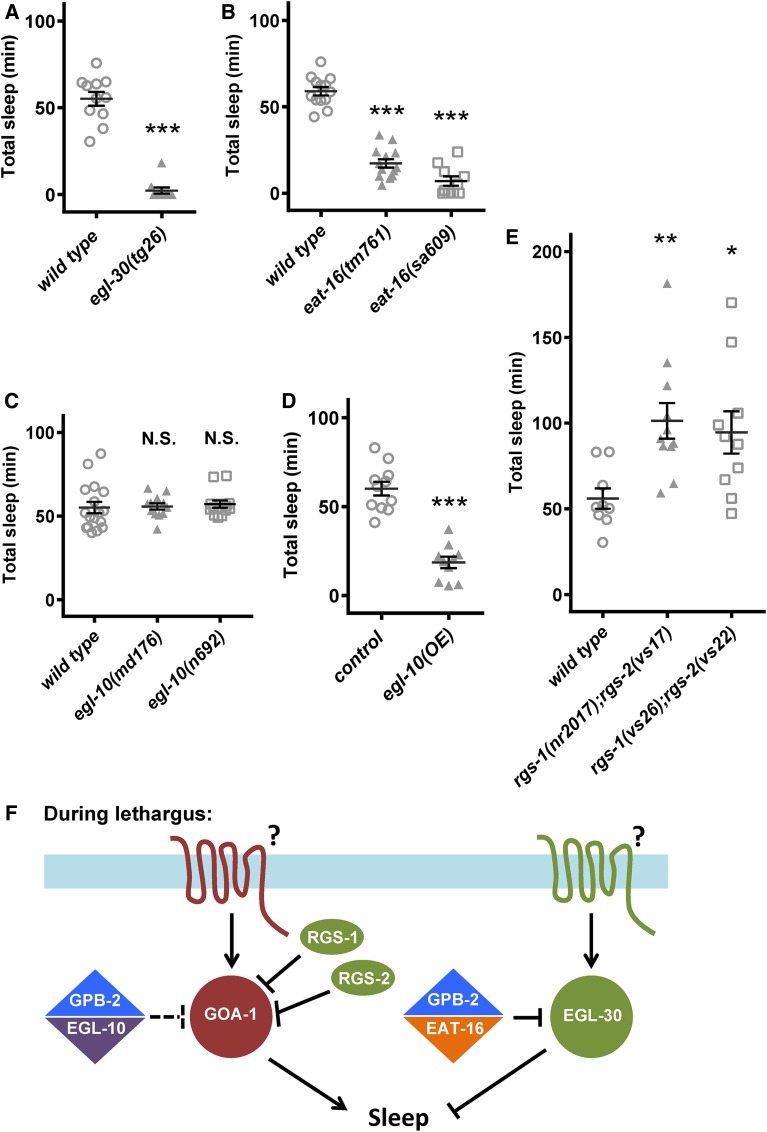
GPB-2 and RGS-1/2 regulate Gαq EGL-30 and Gαo GOA-1, respectively, in L4/A lethargus sleep. (A) egl-30(tg26) gain-of-function animals had dramatically decreased total sleep during L4/A lethargus in microfluidic chamber assays, consistent with a previous report. Severe or complete loss of egl-30 causes paralysis or lethality. (B) Loss of function in the RGS protein EAT-16 led to decreased L4/A lethargus sleep, consistent with EAT-16 loss leading to increased EGL-30 Gαq activity. (C) Loss of RGS protein EGL-10 function had no impact on L4/A lethargus sleep, suggesting that other RGS protein(s) regulate pertinent Gαo GOA-1 activity. Only L4/A total sleep is shown here, but lethargus duration and sleep bouts duration were also not affected (data not shown). (D) Increasing EGL-10 RGS protein activity, using a previously described overexpression strain, was sufficient to decrease L4/A lethargus sleep. (E) Simultaneous loss of both RGS-1 and RGS-2 (RGS-1/2) led to increased sleep. Two previously described double mutant strains were examined. Increased sleep observed here is consistent with RGS-1/2 loss leading to increased GOA-1 Gαo activity (due to decreased GTP hydrolysis), which would cause more sleep. Mean and SEM indicated, along with results for individual animals for each genotype. * P < 0.05, ** P < 0.01, *** P < 0.001 by Student’s t-test vs. control or wild-type animals run in parallel in multiple trials. (F) G protein pathway signaling pertinent to L4/A lethargus sleep. On the right side of the illustration, Gβ5 GPB-2 and RGS EAT-16 proteins normally act together to increase EGL-30 Gαq GTP hydrolysis, which decreases overall signaling via EGL-30. EGL-30 Gαq is normally wake-promoting; increased EGL-30 or gain of function drives less sleep. The identity of putative G protein receptor(s) that drive EGL-30 signaling is unclear. On the left side of the illustration, loss of GOA-1 Gαo decreases sleep, suggesting that GOA-1 Gαo and effectors are normally sleep-promoting. In other behavioral contexts, Gβ5 GPB-2 and RGS EGL-10 proteins act together to regulate GOA-1 Gαo activity, but loss of EGL-10 had no impact on L4/A lethargus sleep. However, loss of both RGS-1 and RGS-2 function altered sleep suggesting that at least one of these RGS proteins acts to increase GOA-1 Gαo GTP hydrolysis, which would decrease overall signaling via GOA-1 and downstream effectors. The GPCR receptors that drive increased GOA-1 Gαo activity are also unknown. The balance of the Gαq and Gαo signaling is a major factor in determining the quantity of sleep seen in L4/A lethargus.